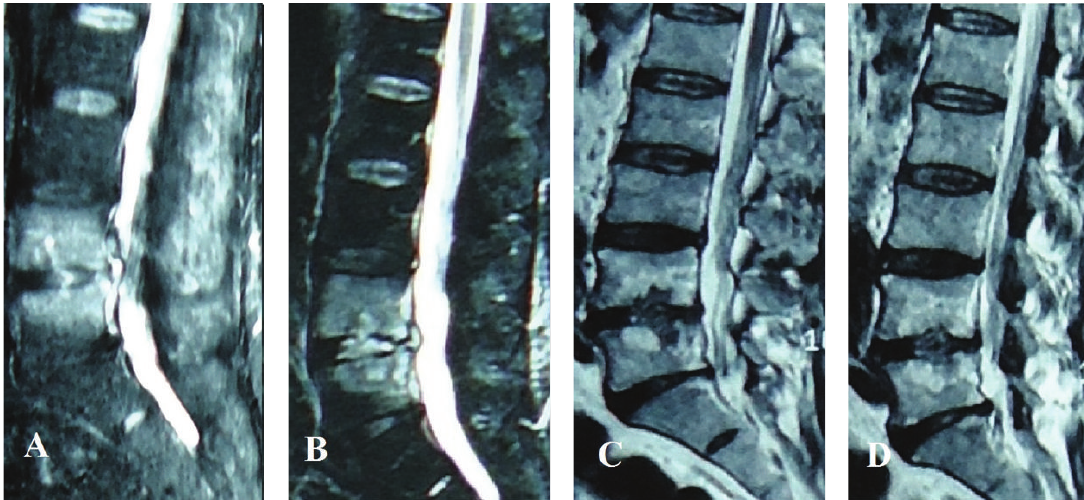
Figure 1: (A) Discitis and osteomyelitis are seen on this T2-weighted MR image of the lumbar spine which demonstrates infective destruction of the L4-5 disk space with the adjacent L4 and L5 vertebral bodies. (B) T2-weighted MR image of the lumbar spine demonstrates diskitis and osteomyelitis persisting despite 4-week treatment of ceftazidime and vancomycine. (C) Eight weeks after the treatment of teikoplanin. T2-weighted MR image of the lumbar spine demonstrates significant resolution in signs of discitis and osteomyelitis. (D) Nine months after the diagnosis. T2-weighted MR image of the lumbar spine demonstrates no recurrence of discitis or